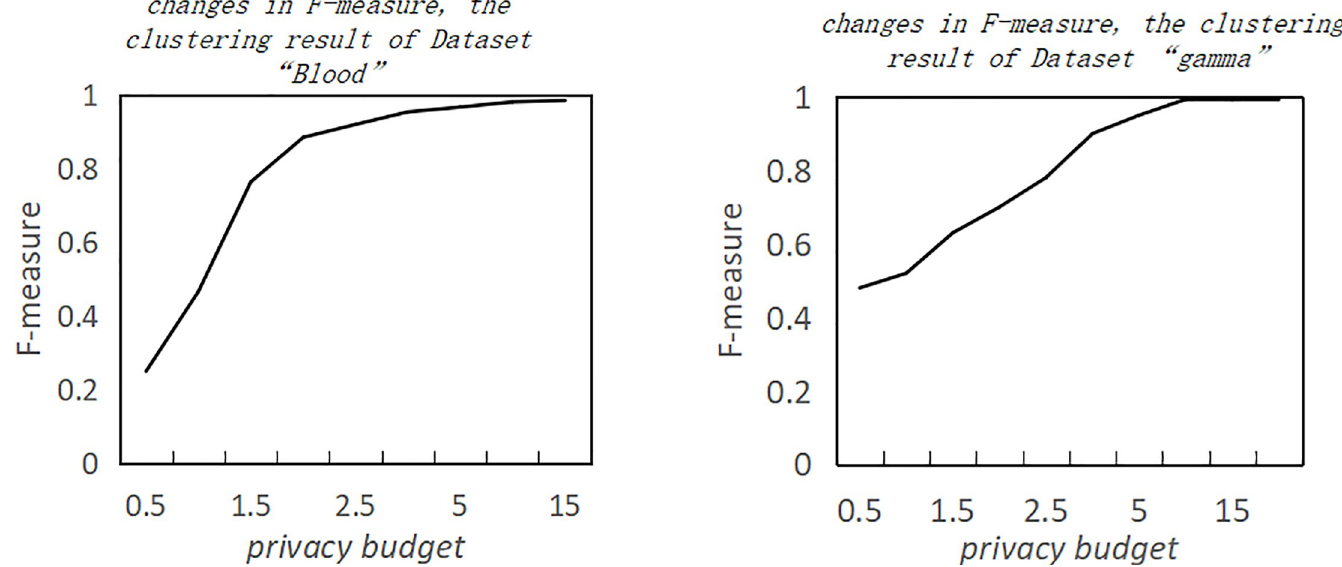
Fig 2. Effect of privacy budget on the functions of different dataset.